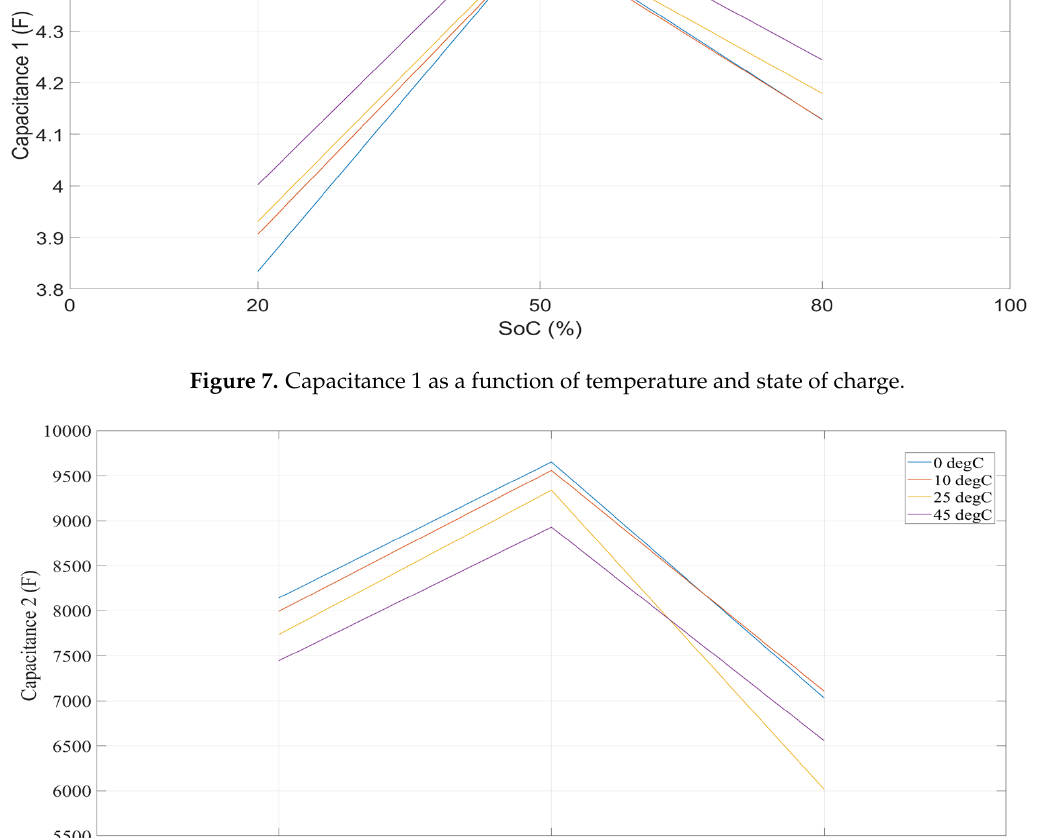
Figure 8. Capacitance 2 as a function of temperature and state of charge.